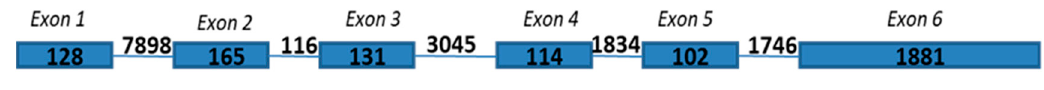
Figure 1. Structure of the NQO 1 gene, NG_011504.2.